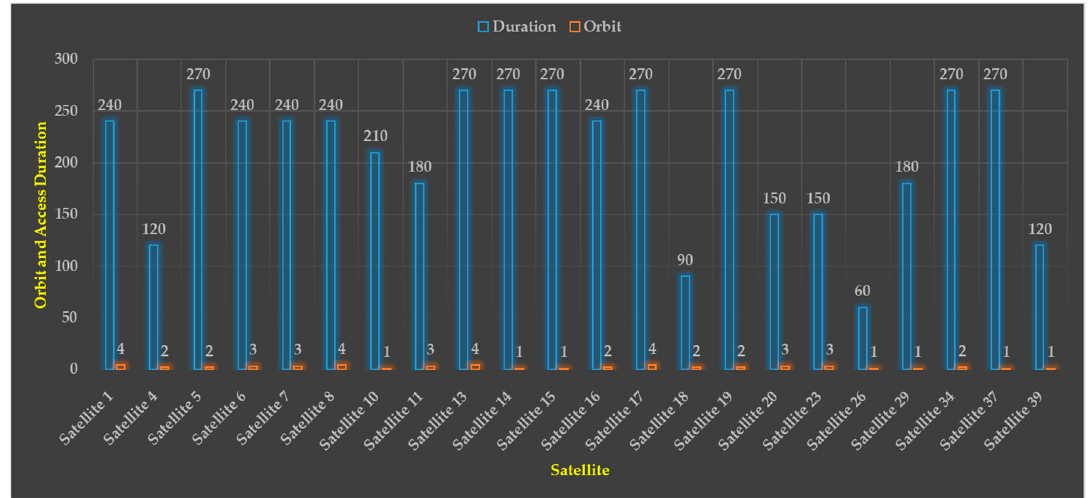
Figure 14. Australia satellite access duration with reconfiguration and its orbit.